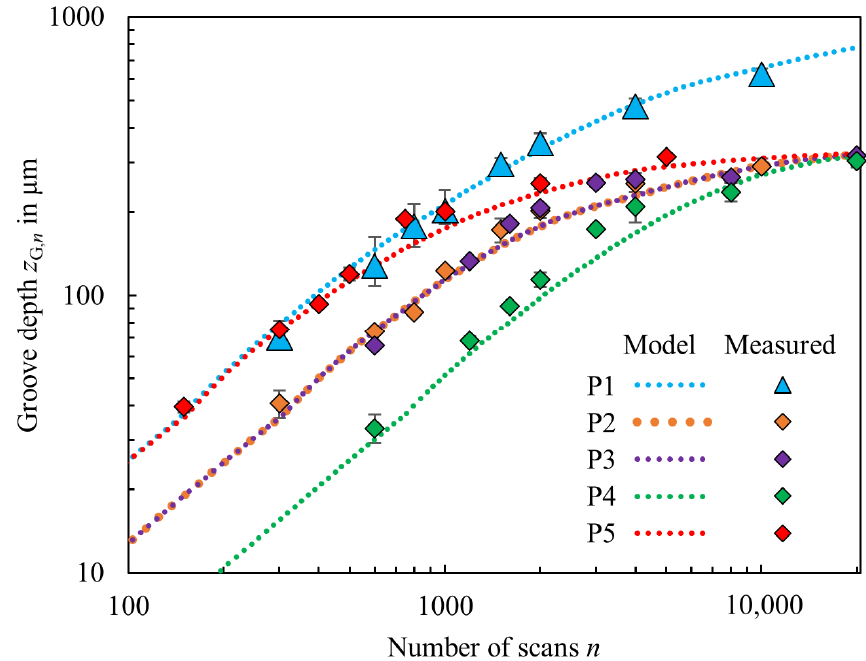
Figure 4. Calculated groove depth (dotted lines, “Model”) and measured groove depth (data points, “Measured”) as a function of the number of scans for grooves micromachined in Ti6Al4V using the different parameter sets as given in Table 1.